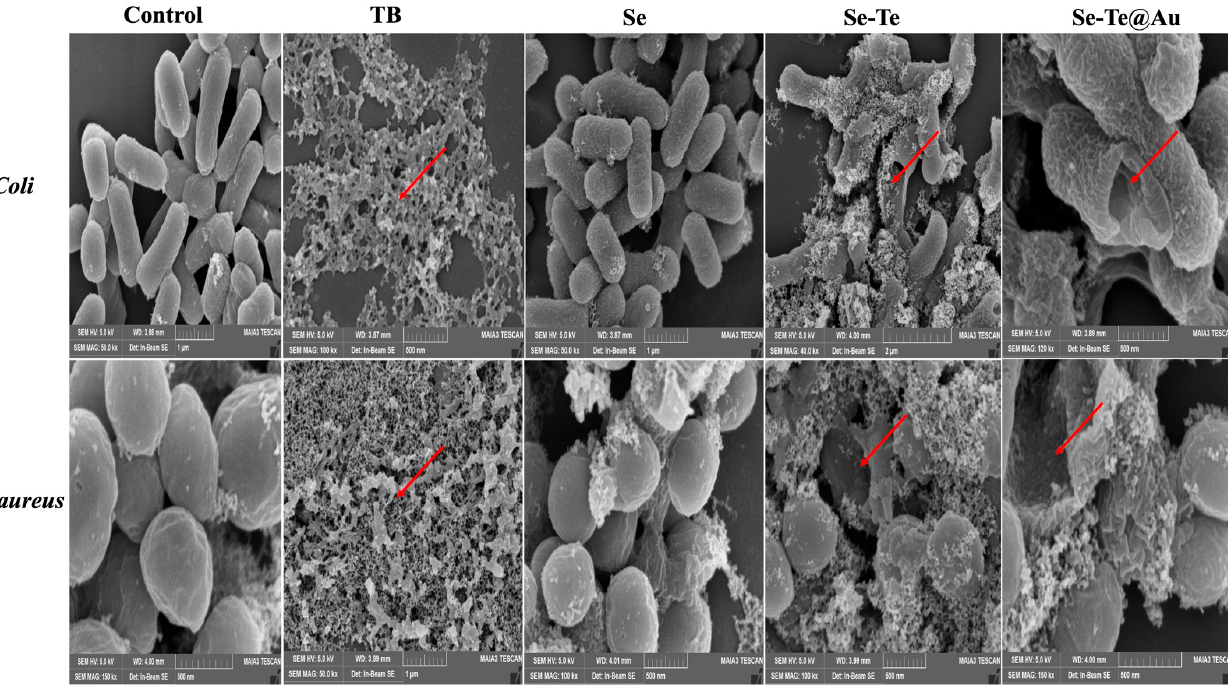
Figure 7. SEM images of E. coli control, TB, and S. aureus treated with Se, Se-Te, and Se-Te@Au nanoparticles; red arrows point towards cell leakage and severe disruption of cell membrane.